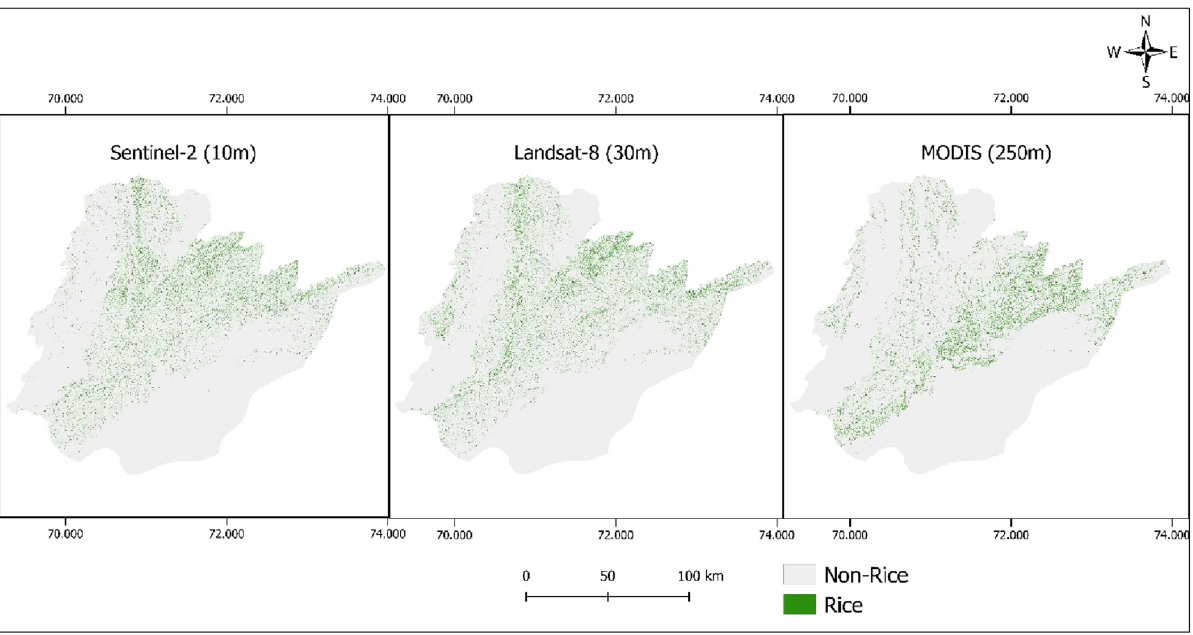
Figure 8. Rice crop map in southern Punjab for the year 2020 using Sentinel-2, Landsat-8 and MODIS